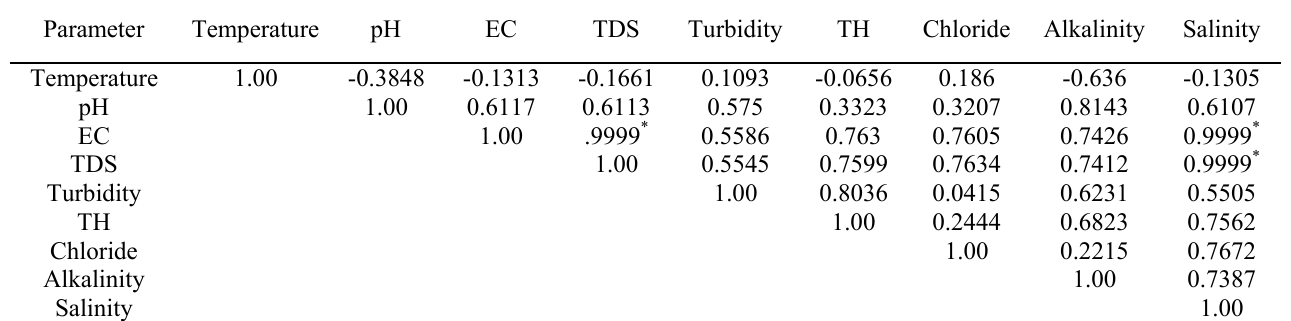
Table 4. Correlation matrix for various water quality parameters